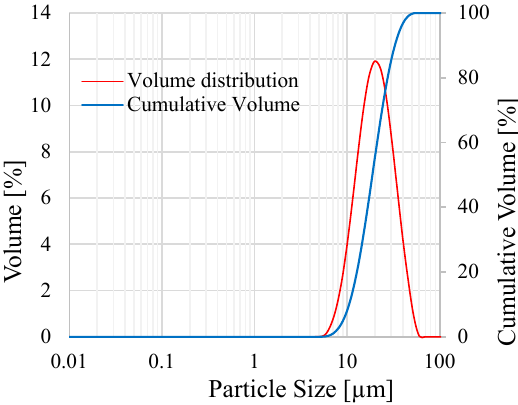
Figure 1. Size distribution of Ti64 powder particles.